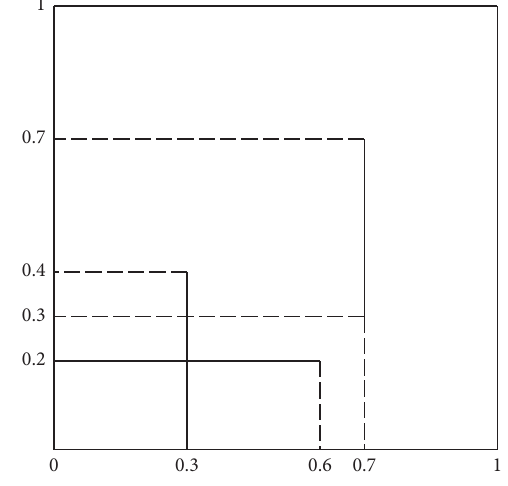
Figure 6: Configuration of the reservoir.